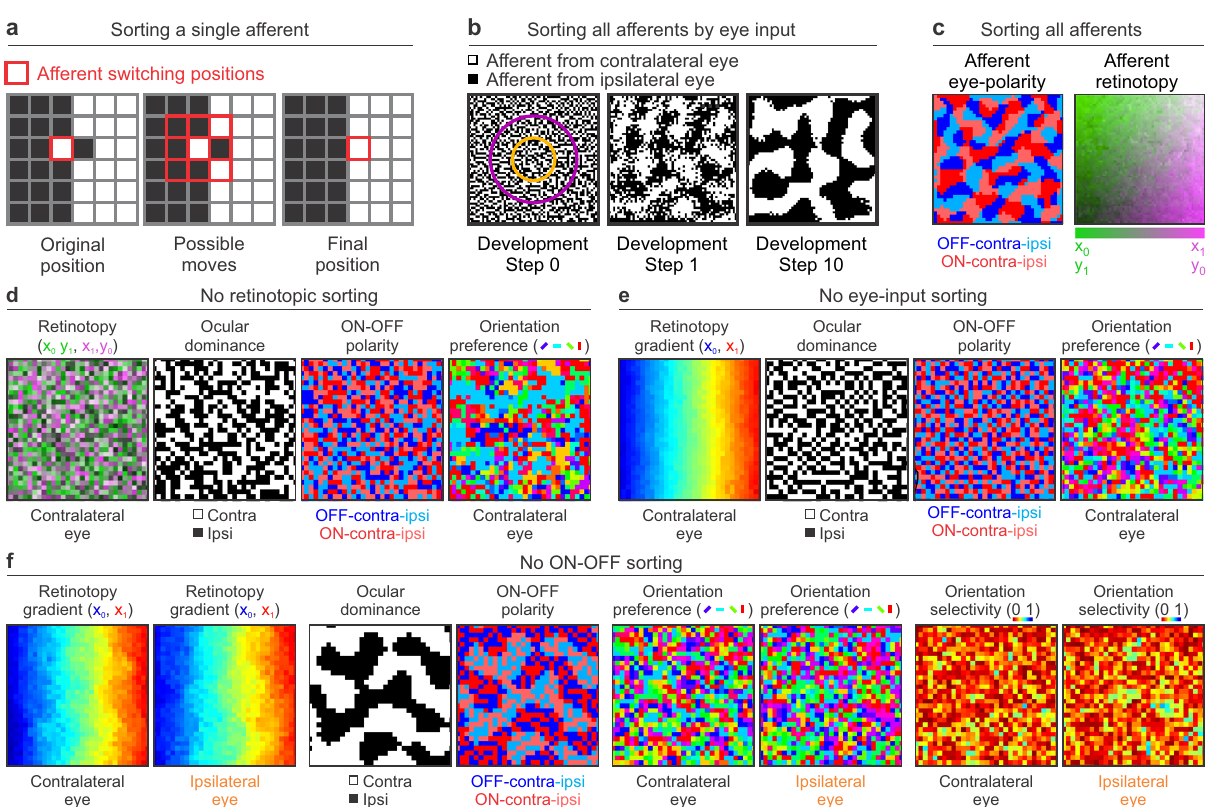
Fig. 4 Second model stage. Afferent sorting in the cortical subplate. a The model sorts afferents by retinotopy, eye input and ONOFF polarity. The sorting by eye input is done by performing a convolution between an afferent sorting fi lter and a binary randomized cortical subplate that assigns values of 1 to afferents from the contralateral eye (black pixels) and -1 to afferents from the ipsilateral eye (white pixels). The model selects an afferent (left, red outline) and computes the convolution at 9 neighboring positions (middle). Then, it selects the position that gives the highest convolution value (right), which is the position where the afferent is surrounded by the largest number of afferents of the same type. b Sorting of afferents by eye input in a larger cortical plate. The afferent sorting is performed in 10 developmental steps based on the convolutions with the afferent sorting fi lter (concentric purple and orange circles on the left). The afferents are randomly organized at step 0 (left), start segregating at step 1 (middle) and the segregation is complete at step 10 (right). c The same sorting method is used for ONOFF polarity. At the end of the sorting process, afferents are segregated by eye input and ONOFF polarity (left) in addition to retinotopy (right). d Random afferent sorting by retinotopy causes random mapping of all stimulus dimensions in simulated visual cortex. From left to right, mapping of retinotopy, ocular dominance, ONOFF polarity and orientation preference for the contralateral eye. e Random afferent sorting by eye input causes random mapping of all stimulus dimensions except retinotopy in simulated cortex. From left to right, normal cortical retinotopy and random mapping for ocular dominance, ONOFF polarity and orientation preference. f Random afferent sorting for ONOFF polarity causes random cortical mapping of all stimulus dimensions except retinotopy and eye input. From left to right, pairs of panels showing cortical retinotopy for both eyes, afferent segregation by eye input but not ONOFF polarity, and random mapping of orientation preference and selectivity for both